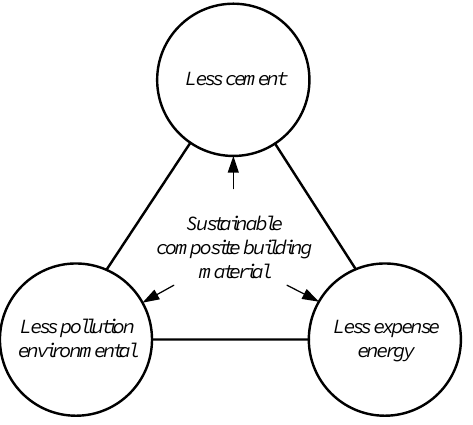
Fig. 5. Model of sustainable composite material using sulphur and plant origin